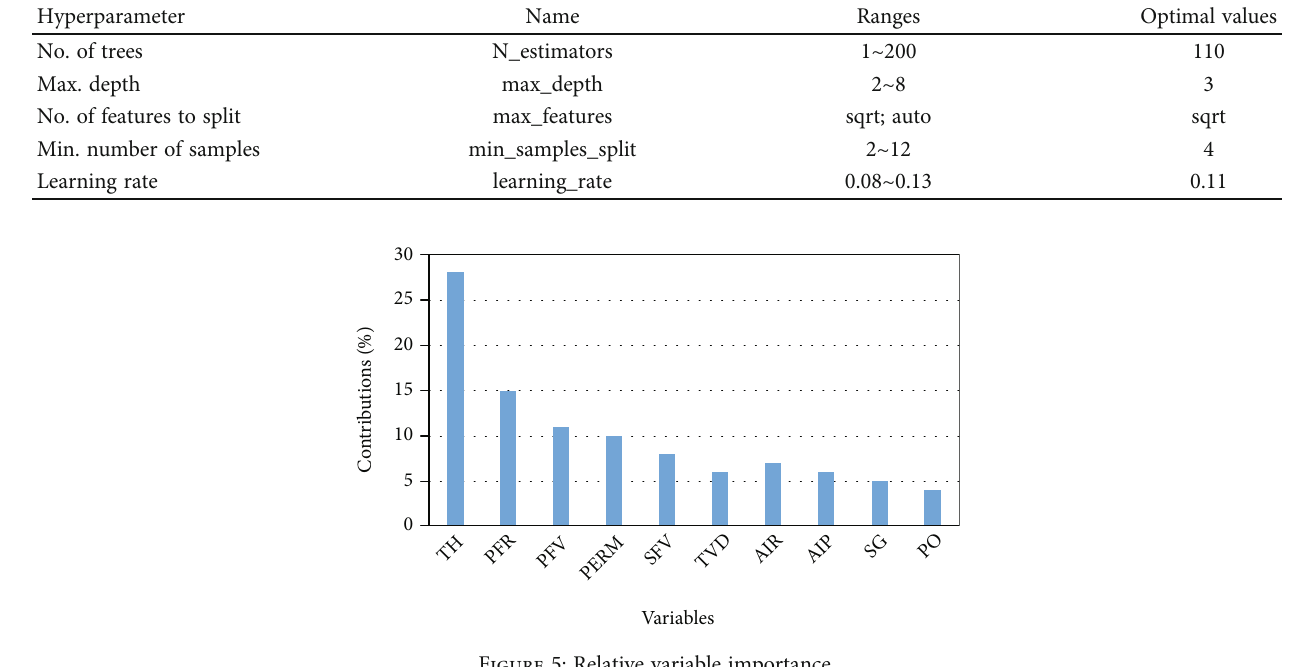
Figure 5: Relative variable importance. Table 4: Properties of well Sudong42-48.